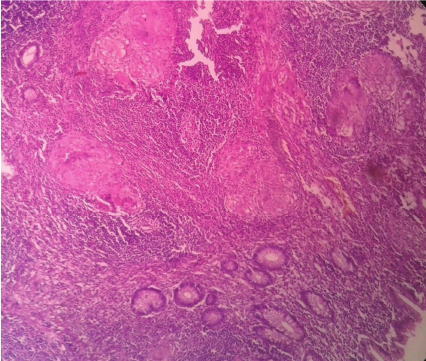
Figure 2: Histopathological examination of appendix showing numerous granulomas in the wall at low power.